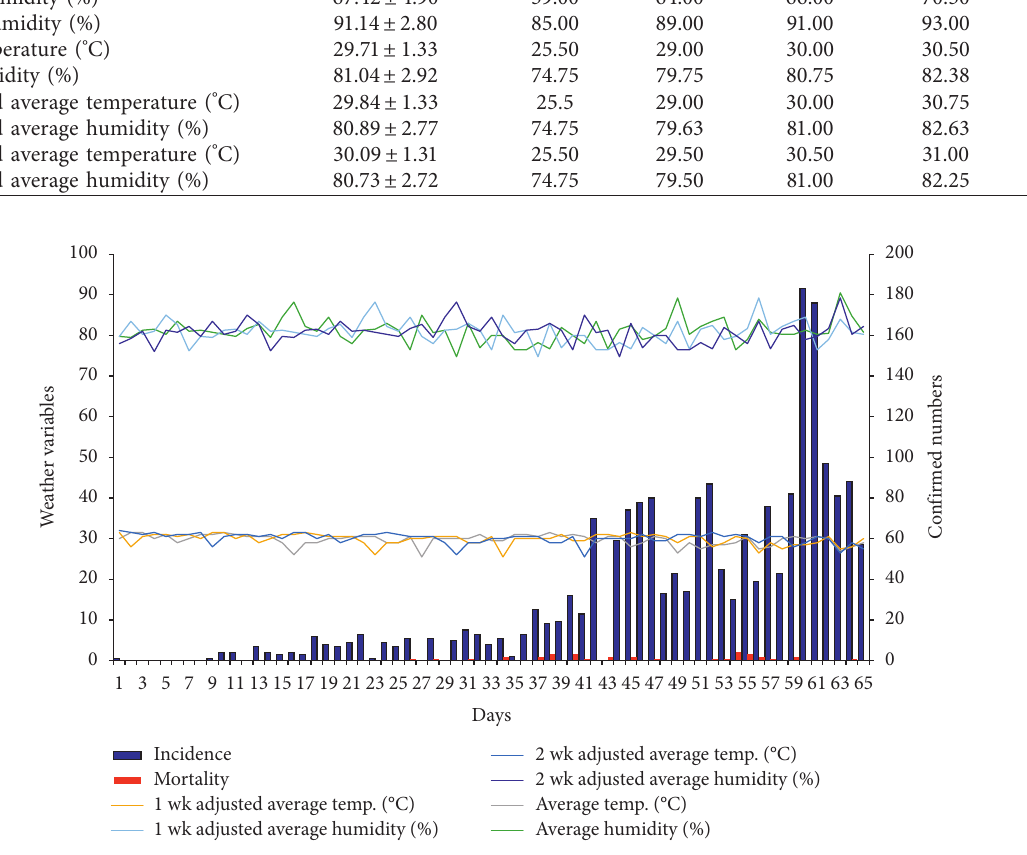
Figure 1: Temporal pattern of COVID-19 incidence, mortality, and meteorological factors (temperature and humidity) between 9 th March and 12 th May 2020 in Lagos